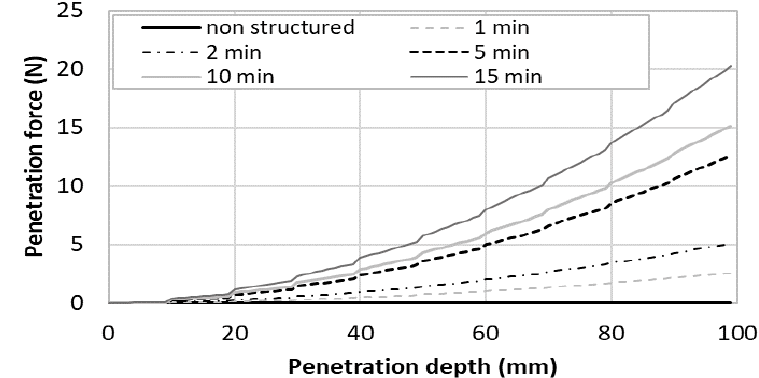
Figure 4. Static yield stress evolution of mortars representative of a fluid accelerated one (Mortar 1) and a firm one used in the infinite brick method (Mortar 2).